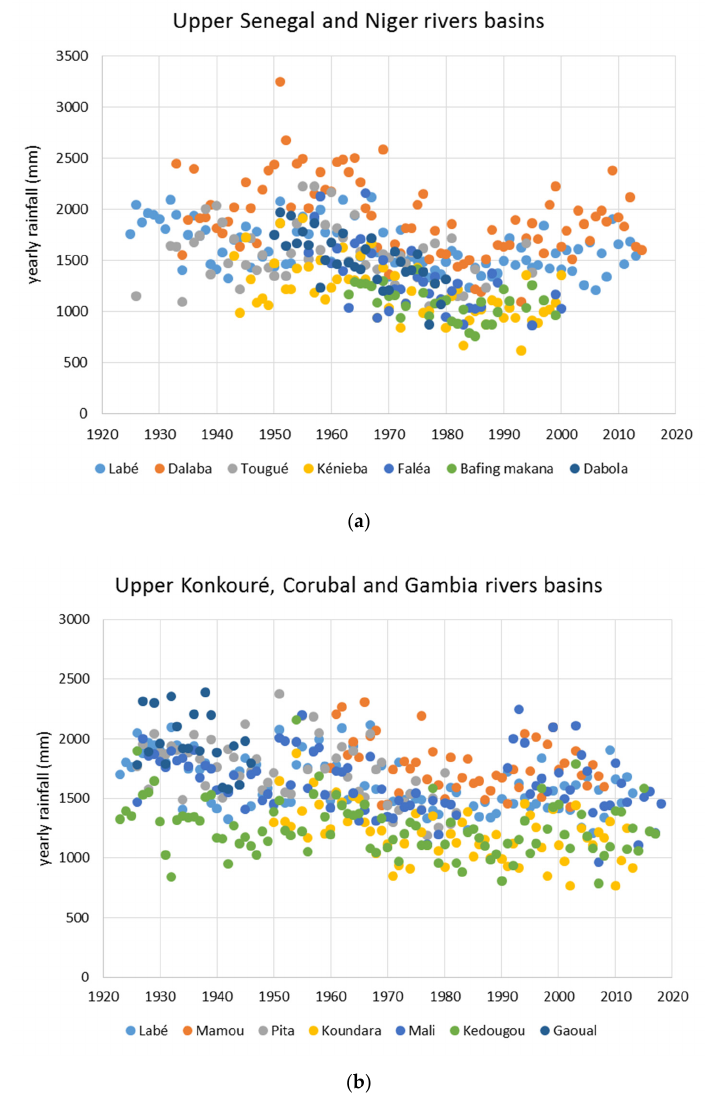
Figure 3. Rainfall evolution in the Fouta Djallon mountains since 1923; ( a ) Senegal and Niger upper basins. ( b ) Konkouré, Corubal, and Gambia rivers basins. Dots represent the annual total rainfall (ATR), in mm.